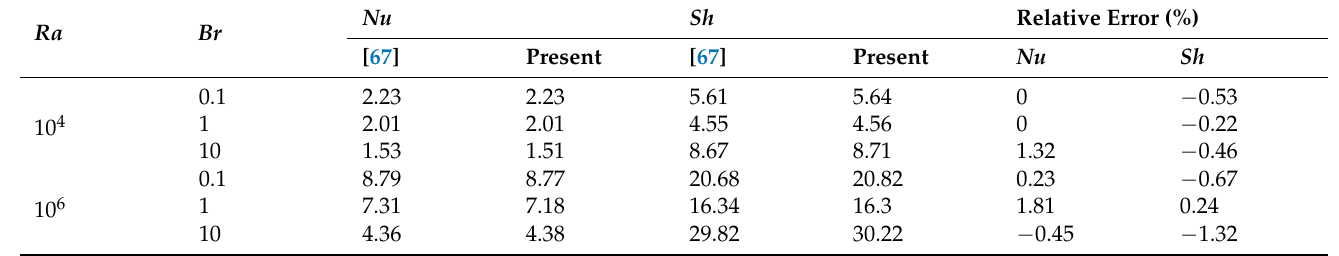
Table 1. Comparison of the double-diffusive convection of the average Nusselt number and contami- nant Sherwood number between Corcione et al. [67] and the present work.